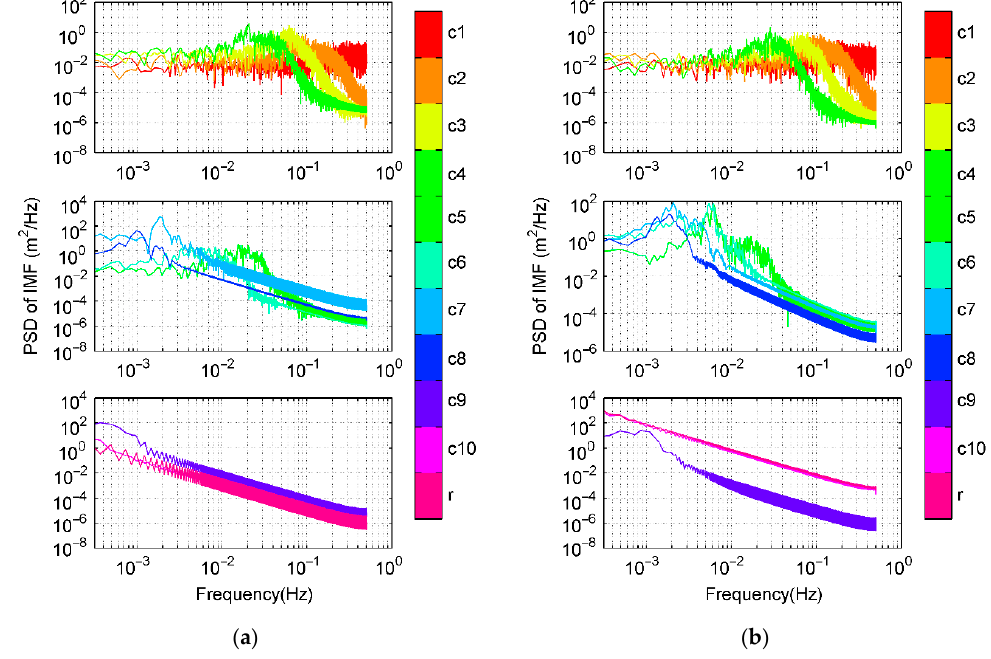
Figure 9. PSD for each decomposed layer from CMC using HHT. ( a ) C09 and ( b ) G19.